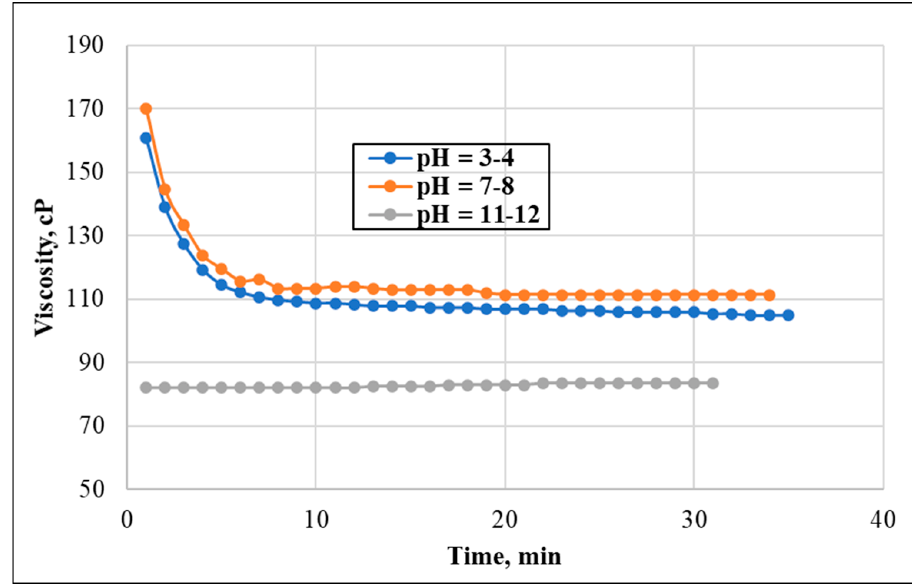
Figure 7. Effect of pH on the solution viscosity (shear rate= 100 s − 1 , temperature= 150 °F, GLDA concentration= 10 wt.%, and CMHPG concentration= 50 pptg).